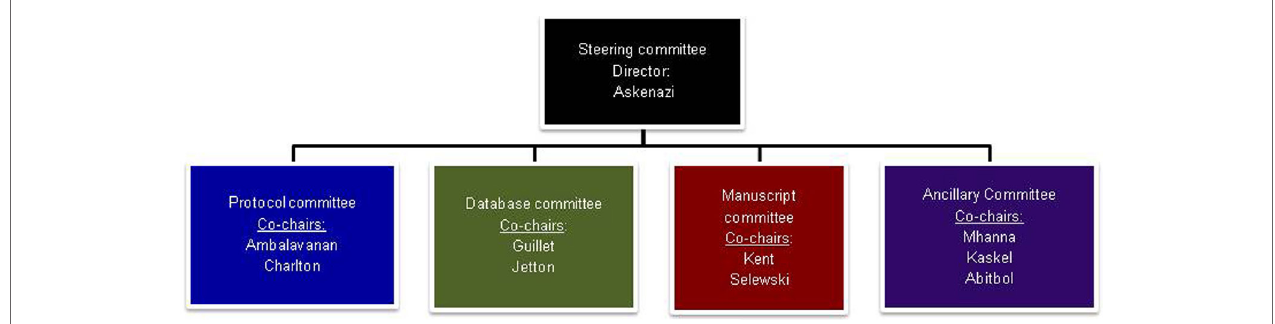
FiGurE 1 | the Steering committee is composed of the director and the co-chairs of each of the sub-committees . The Protocol Committee was tasked to provide oversight and critique of the protocols submitted to the committee, both for the initial retrospective study (AWAKEN) and any future studies. It will also be charged with creating and submitting protocols to funding agencies and Institutional Review Boards. Other responsibilities include establishing rules for Primary Investigator designation and a system for group involvement for the establishment of future protocols. The Database Committee was charged with the development of the database, including the Manual of Procedures and Case Report Forms. Input was solicited from the NKC membership as to the data needed to answer the specific questions of interest for the AWAKEN study. These suggestions were collated and presented to the Steering Committee for final review. The myriad of data potentially available and the number of questions to be answered had the potential for an unwieldy and overwhelming amount of information. Data points that were included were thoroughly vetted by both nephrologists and neonatologists to balance the time of data collection with quality of the data elements. Once agreement was reached, in concert with the Data Management Center at Cincinnati Children’s Hospital Medical Center, electronic data forms were developed, tested, and finalized. The Manuscript Committee is responsible for initiating and developing abstracts for national and international meetings and manuscripts for submission to peer-reviewed journals. This committee will also review these abstracts and manuscripts prior to submission and provide the authors suggestions, as well as determine their suitability. The Ancillary Studies Committee will be responsible for developing rules on requesting use of data for ancillary studies and in developing these ideas into abstracts and